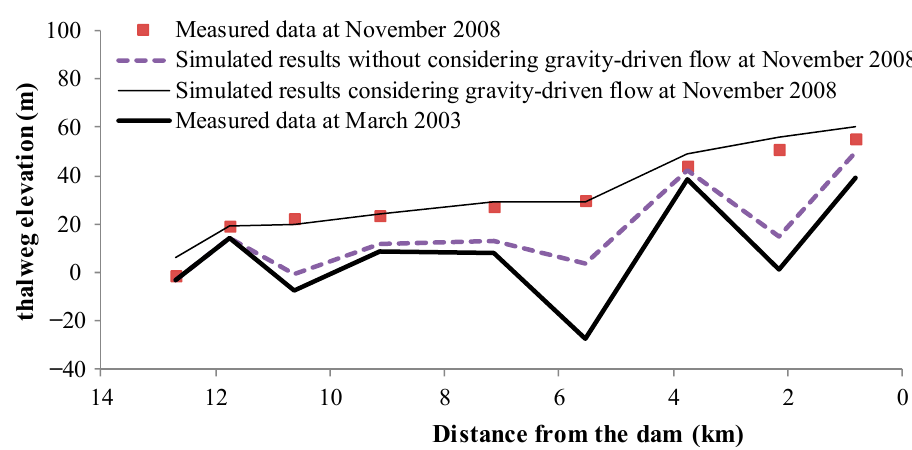
Figure 13. Computed and observed elevations of the thalweg.